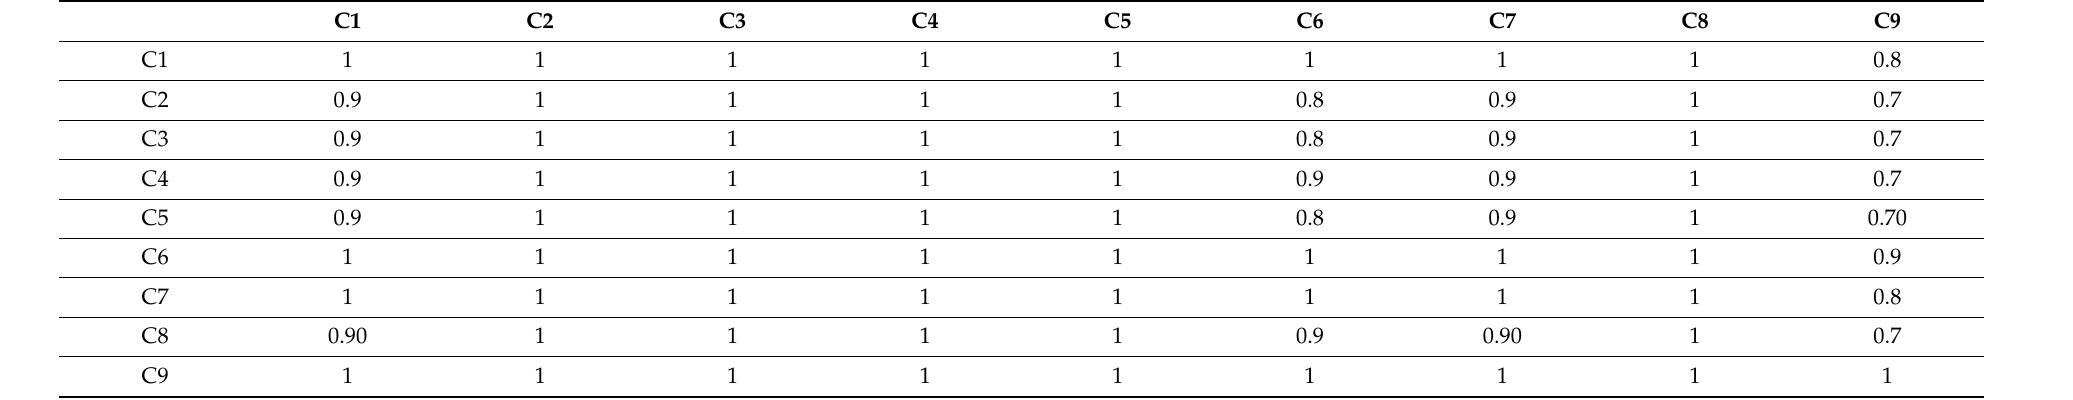
Table A5. Causes–cause matrix to